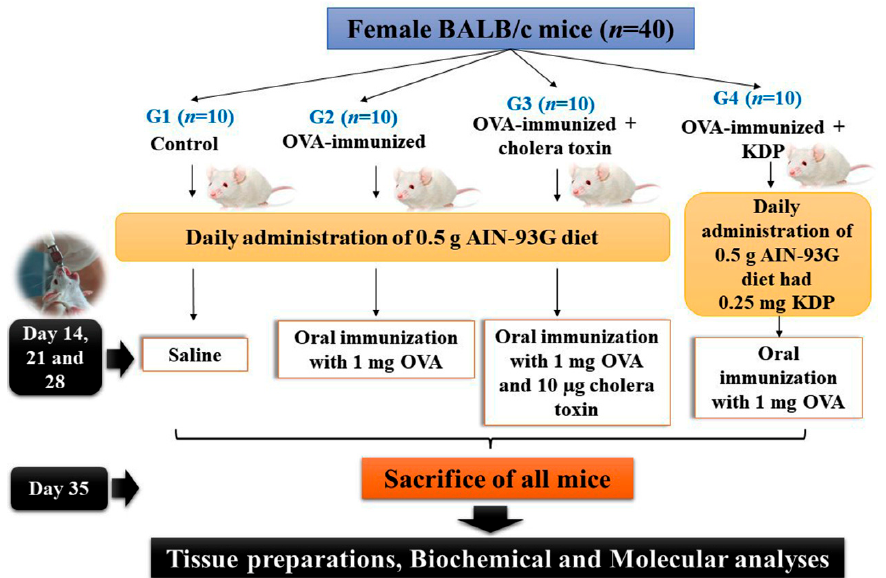
Figure 1. Schematic diagram of experimental design.